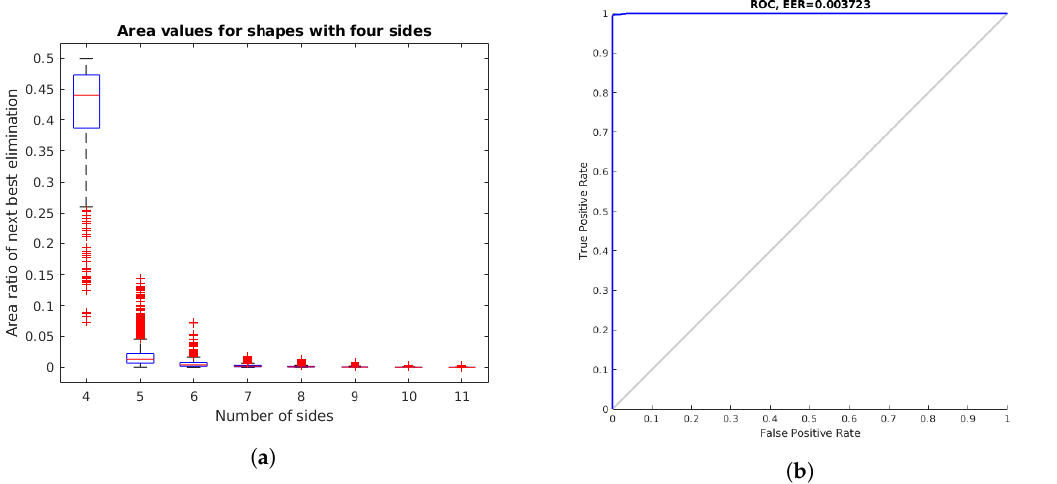
Figure 8. Area ratio of next best elimination for different sides of contours corresponding to shapes with four sides. Most of the polygonal shapes were correctly identified as quadrilaterals, with an equal error rate (EER) of 0.003723. ( a ) Boxplot; and ( b ) receiver operating characteristics for the classification of four-side